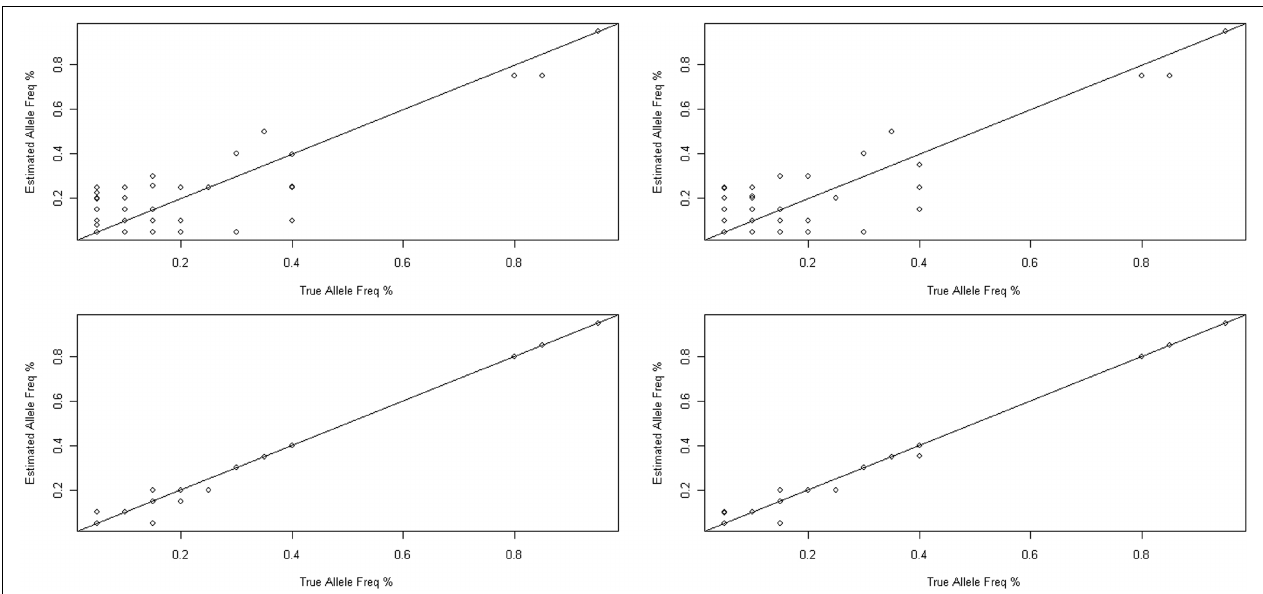
FIGURE 4 |Accuracy of allele frequencies estimated from the pre- (upper) and post-PCR pooling (below). The allele frequency as determined by